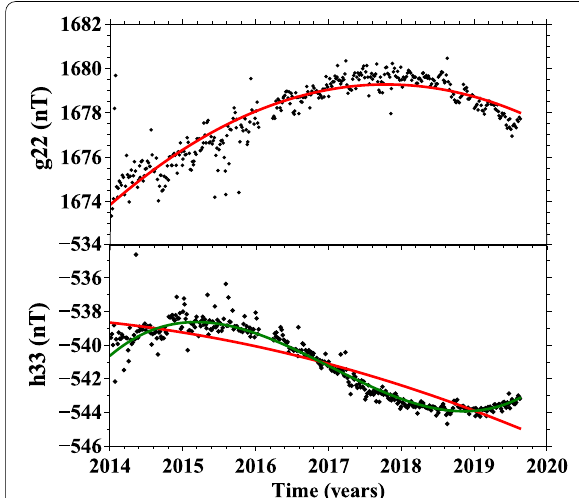
Fig. 3 Example of spherical harmonic h33 fitting. Red line shows the parabolic fit to data. Points outside dotted green lines were not used in the final fitting for h33 and SV33